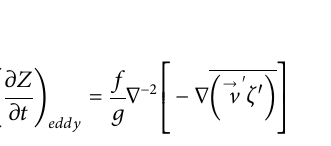
Frontiers in Earth Science |